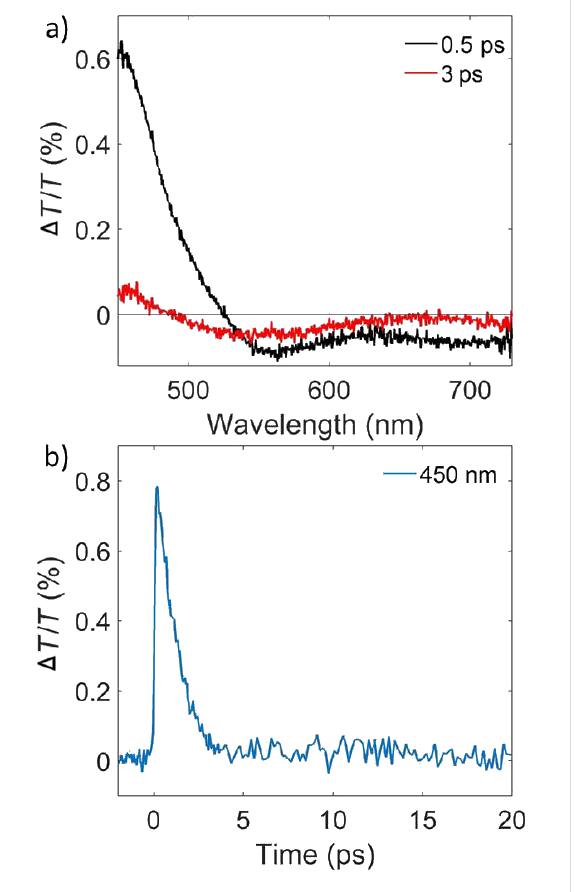
Figure 3: (a) Pump–probe spectra at different time delays and (b) pump–probe dynamic at 450 nm of the ITO–(Ag nanoparticle/TiO 2 nanoparticle) 5 –ITO photonic